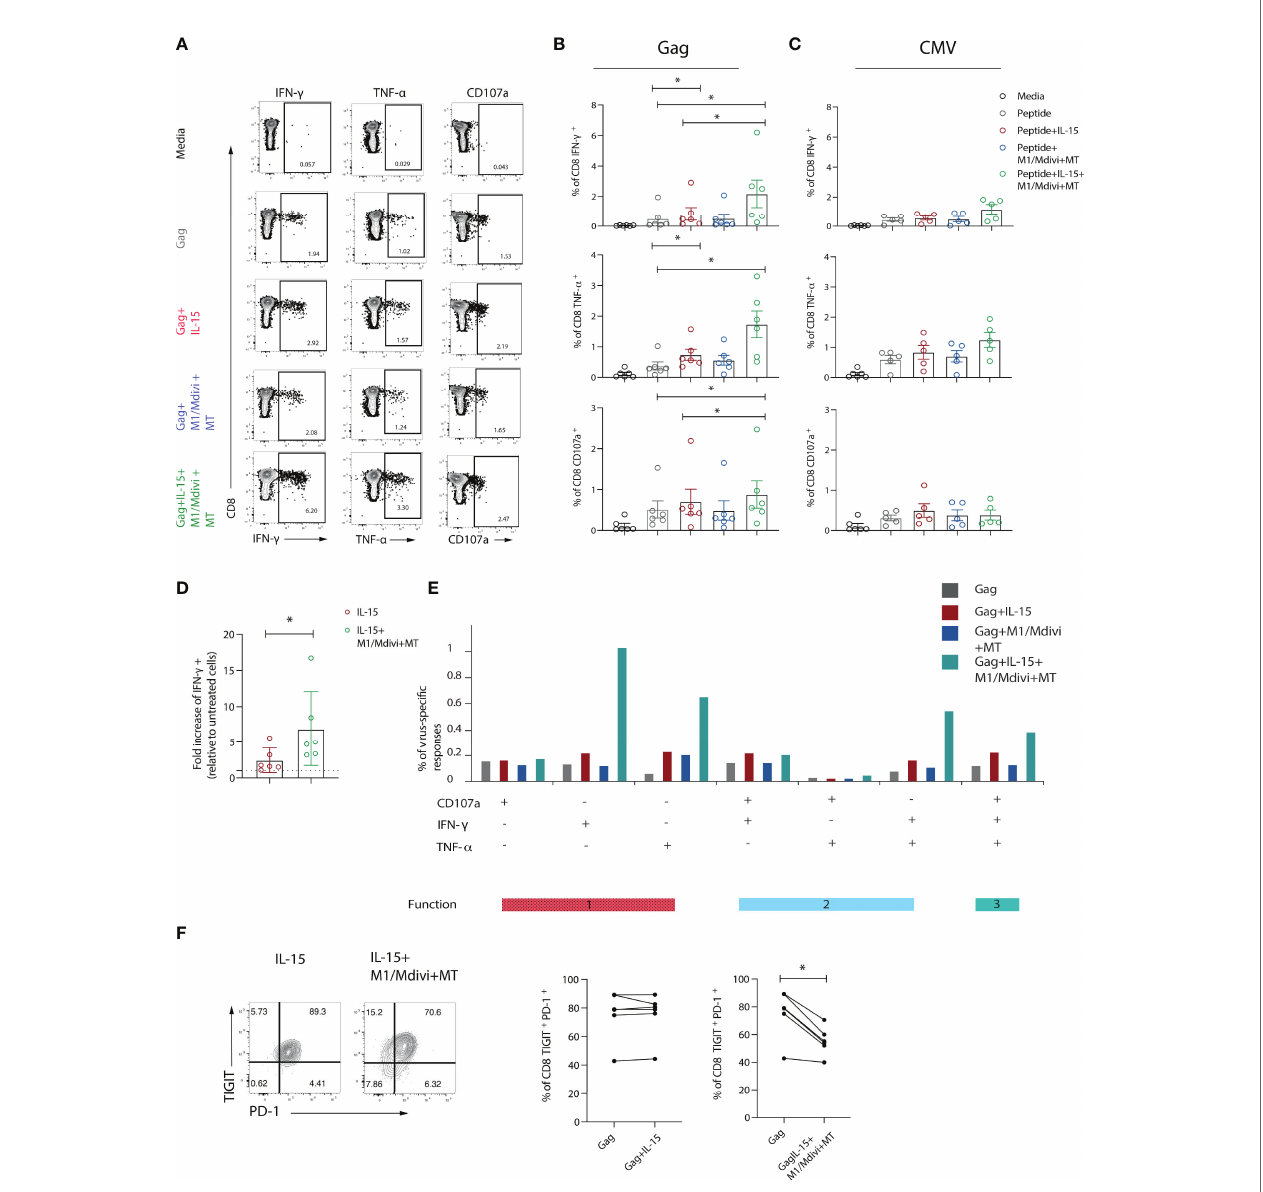
FIGURE 5 | Targeting mitochondrial dysfunction in combination with IL-15 improves functional capacity of exhausted HIV-speci fi c CD8 T cells. (A) Representative fl ow plots and (B) Summary data showing percentage of IFN- g , TNF- a and CD107a positive CD8 T cells after 6-hour stimulation with Gag peptides in the presence or absence of IL-15, and M1, mdivi and MitoTempo (M1/Mdivi+MT). (C) Summary data showing the percentage of IFN- g , TNF- a and CD107a positive CD8 T cells after 6-hour stimulation with CMV (pp65) peptides in the presence or absence of IL-15, and M1, mdivi and MitoTempo (M1/Mdivi+MT). (D) Fold increase of the level of IFN- g response to Gag peptide stimulation upon treatment with IL-15 alone (IL-15) or combined with M1, mdivi and MitoTempo (IL-15+M1/Mdivi+MT). (E) SPICE bar charts of IFN- g , TNF- a and CD107a responses in Gag-speci fi c CD8 T cells showing 1 function, 2 functions, or 3 functions of following treatment with different conditions. (F) Representative fl ow plots and summary data of percentage of TIGIT + PD-1 + co-expression in Gag-speci fi c CD8 T cells in the presence of IL-15 (IL-15) alone or combined with M1, mdivi and MitoTempo (M1/Mdivi+MT). Wilcoxon matched-pairs signed rank test, *p <